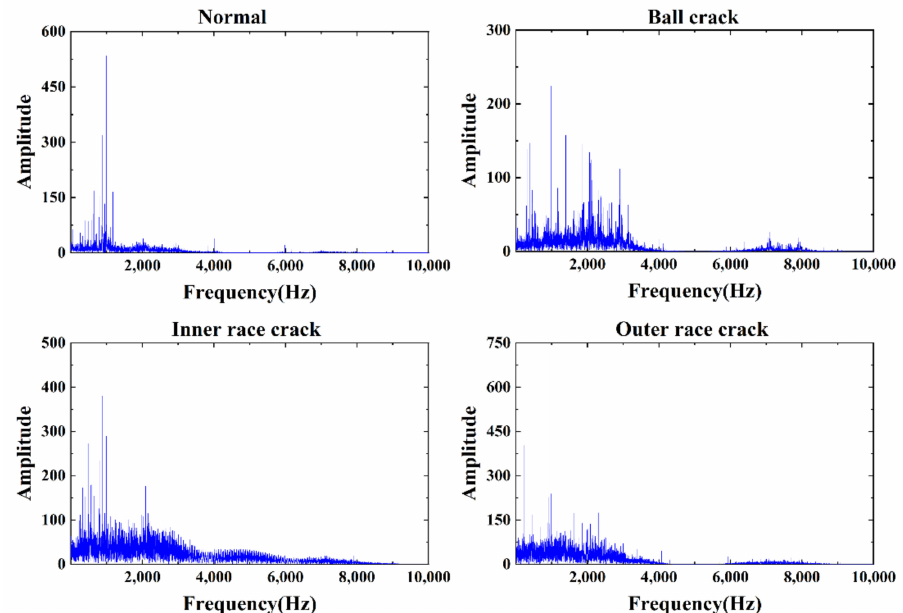
Figure 6. Wavelet de-noising frequency domain waveforms of IMS bearing test raw